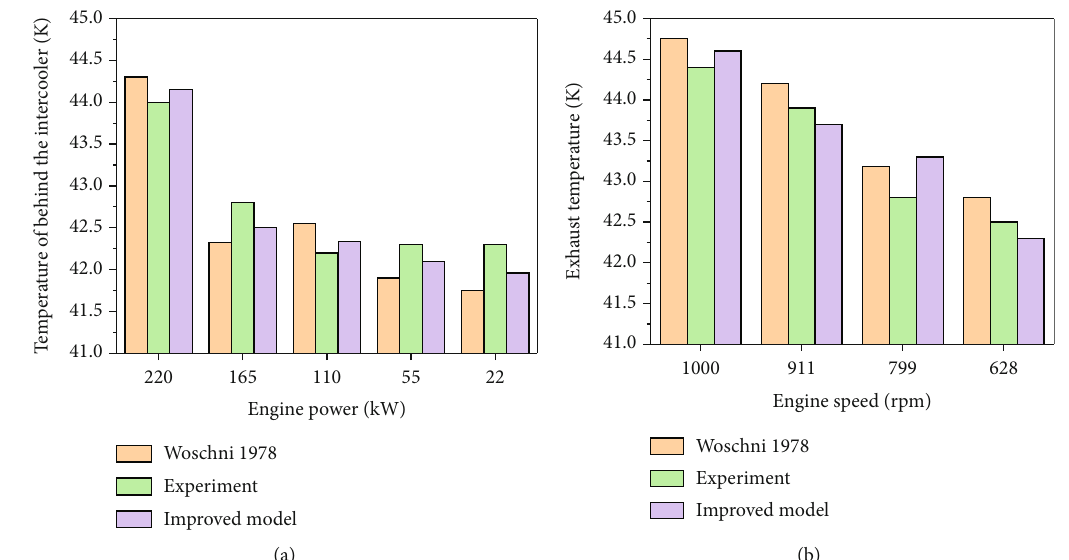
Figure 8: Variation of temperature of behind the intercooler with di ff erent